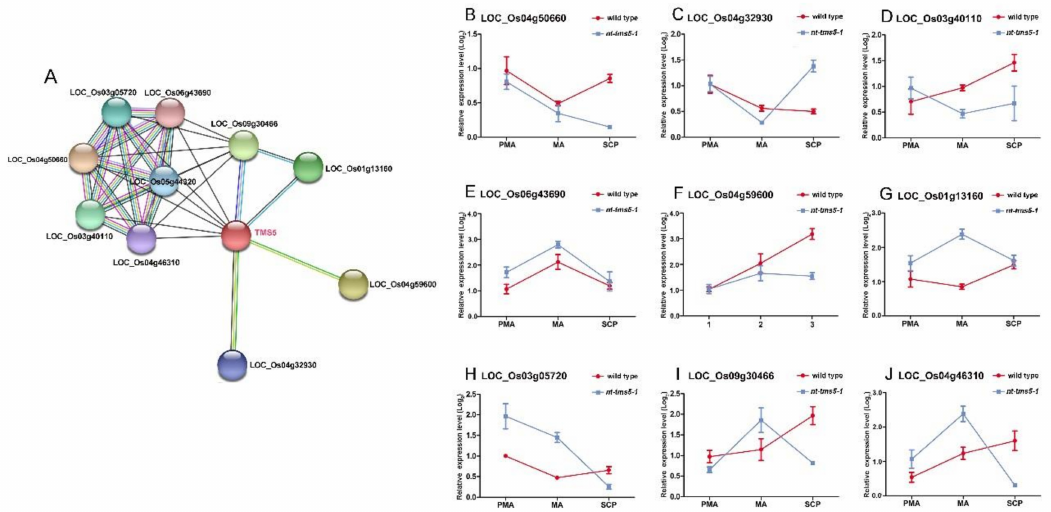
Figure 8. Verification of the predicted TMS5 regulation network during the pollen development process in nt-tms5-1 and its wild type. ( A ) Predicted protein–protein interaction network of the TMS5 gene. Colored lines indicate the interaction proved by experiments, and grey lines indicate the predicted interaction. ( B – D , F ), indicate a lower gene expression level in nt-tms5-1 compared with its wild type. ( E , G – J ), indicate a higher gene expression level in nt-tms5-1 compared with its wild type. PMA, the pre-meiosis stage. MA, the meiosis stage. SCP, single microspore